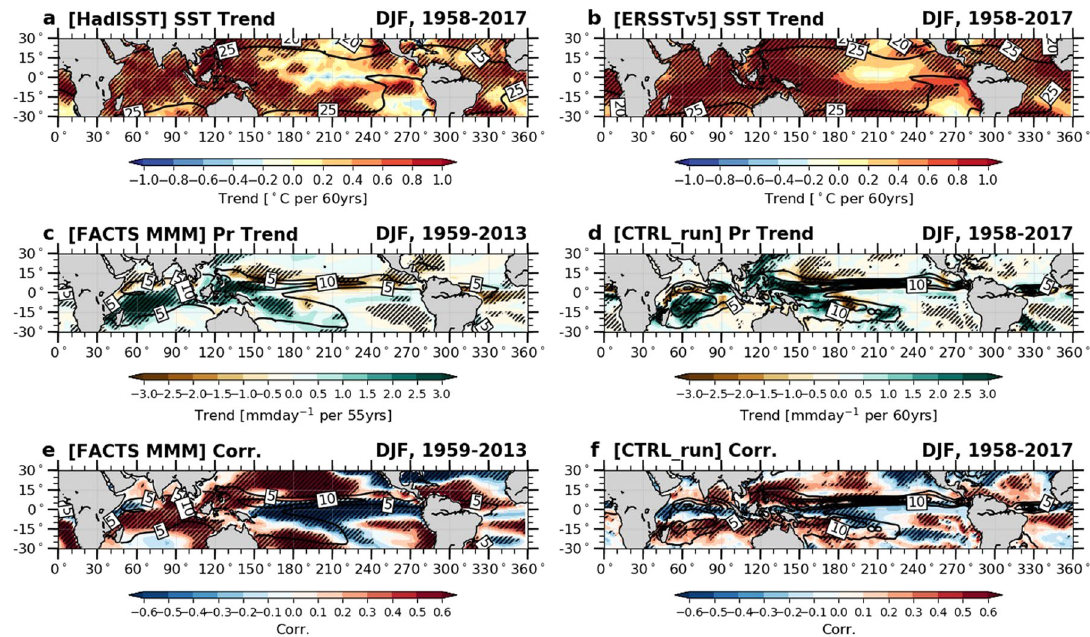
Fig. 2 Long-term trends of observed SST and simulated precipitation with its relationship with AO. The linear trend (shading) of the observed SST (1958 – 2017) in DJF from ( a ) HadISST and ( b ) ERSSTv5 with climatological SST (contour, unit: °C) in each dataset. The linear trend (shading) of simulated precipitation in DJF in ( c ) NOAA FACTS multi-model mean (1959 – 2013) and ( d ) GRIMs CTRL_run (1958 – 2017) with climatological precipitation (contour, unit: mmday − 1 ) in each dataset. The correlation coef fi cients between simulated AO and precipitation in ( e ) NOAA FACTS multi-model mean and ( f ) GRIMs CTRL_run with climatological precipitation (contour, unit: mmday − 1 ) in each dataset. In all fi gures, black hatched regions indicate a statistically signi fi cant region at a 95% con fi dence